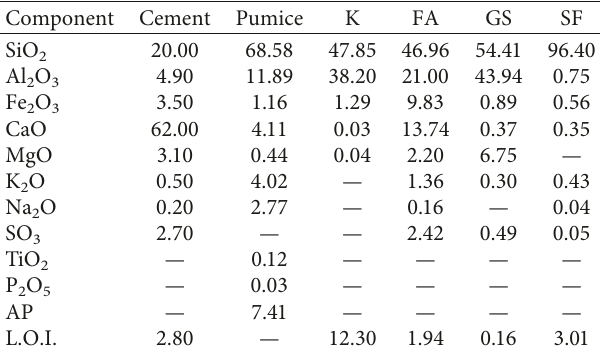
Table 1: Chemical analysis (% w/w) of constituent materials.